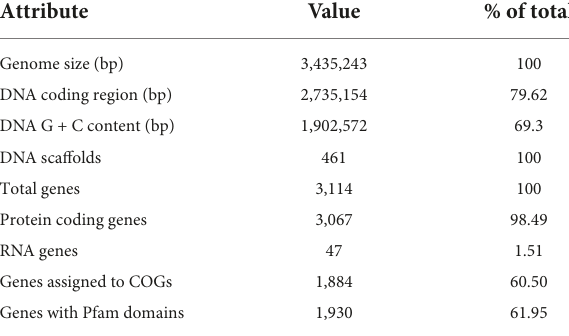
TABLE 1 Arthrobacter sp. UMCV2 genome